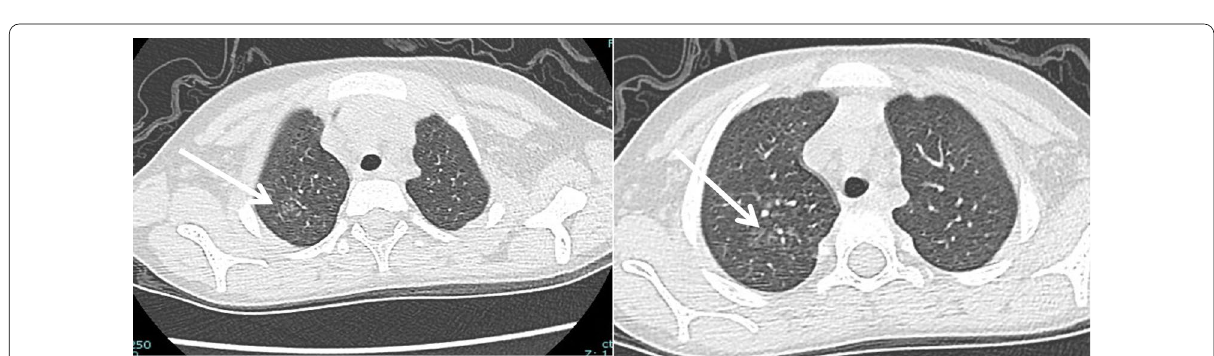
Fig. 7 A 12‑year‑old male child, known case of leukemia, presented with fever for 4‑day duration with mild respiratory manifestation and PCR positive; CT shows unilateral upper lobar centrilobular ground glassing opacities, CT picture is indeterminate for COVID‑19, and CT severity